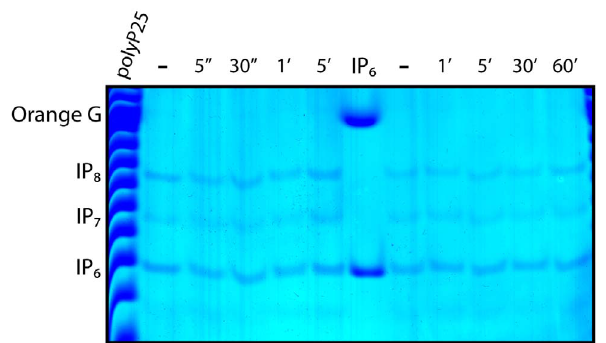
Figure 6. No alteration of IP 7 and IP 8 metabolism after cAMP treatment. Vegetative growing D. Discoideum were incubated for the indicated time with 50 m M cAMP. The incubation was terminated with equal volume of 2M Percloric acid to extract the inositol phosphates. These were resolved on 35% PAGE and stained with Touilidine blue. Two independent experiments are shown with short (left) and long (right) cAMP incubation time. The figure shows the result of a representative experiment that was repeated three times.